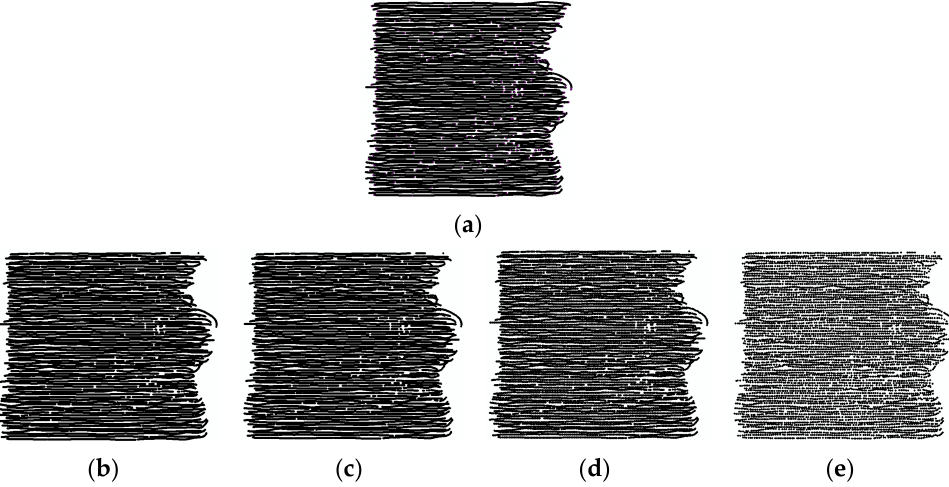
Figure 5. Example of reduced sets of SBES data: ( a ) raw SBES data, ( b ) reduced datasets with R = 0.2 m, ( c ) reduced datasets with R = 1 m, ( d ) reduced datasets with R = 2 m, ( e ) reduced datasets with R = 4 m.